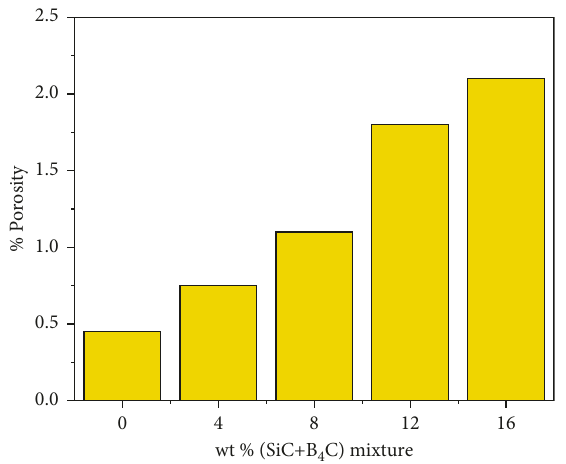
Figure 11: Porosity with variant wt% of (SiC+B